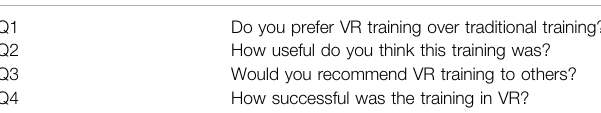
TABLE 6 | Subjective feedback questionnaire.